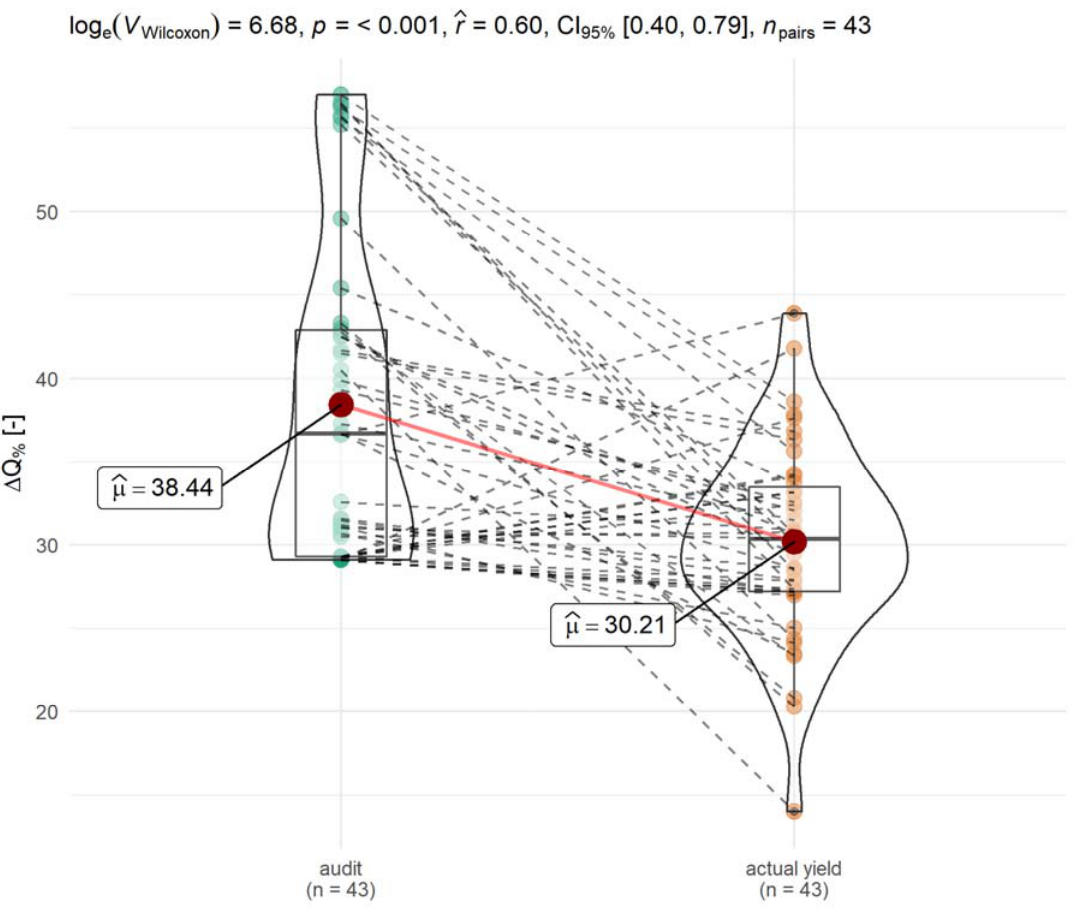
Figure 2. Comparison of the actual decrease in corrected annual energy consumption with the reduction predicted based on the audit.